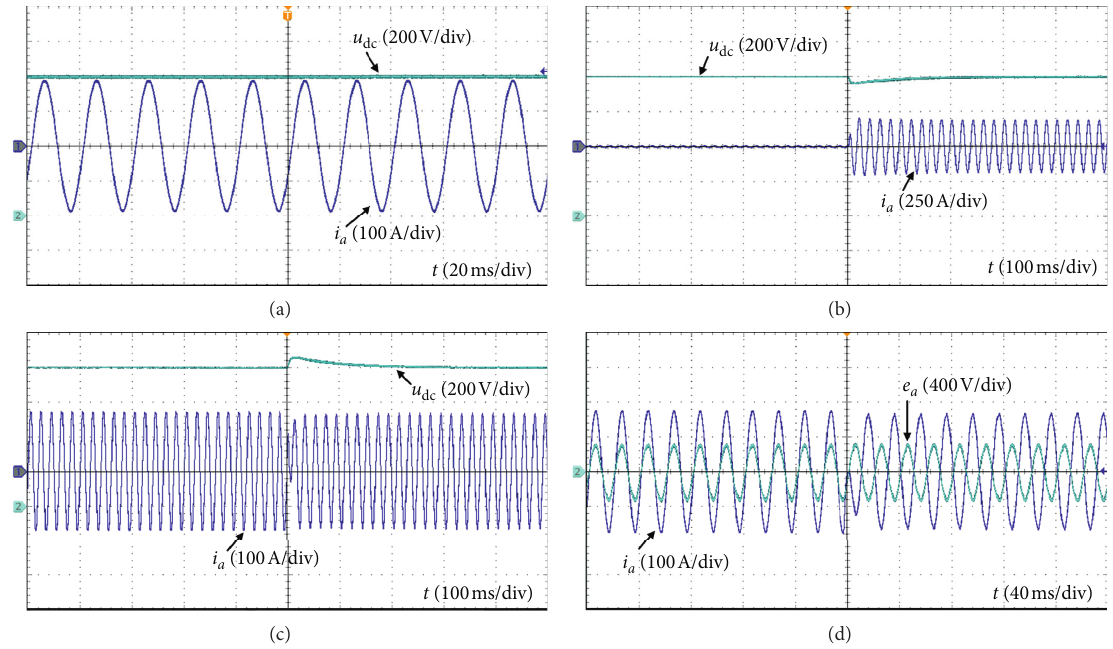
Figure 16: The waveforms of bidirectional AC/DC converters. (a) The grid-connected current and DC bus voltage of converter in full load condition. (b) The DC voltage and grid-connected current of converter in step response. (c) The DC bus voltage and grid-connected current of converter in power flow reverse condition. (d) The grid voltage and grid-connected current of converter in power flow reverse